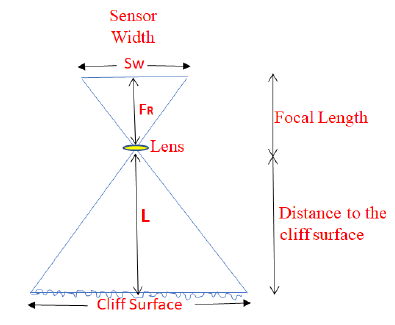
Figure 5 Sensor Width Relative to the FOV